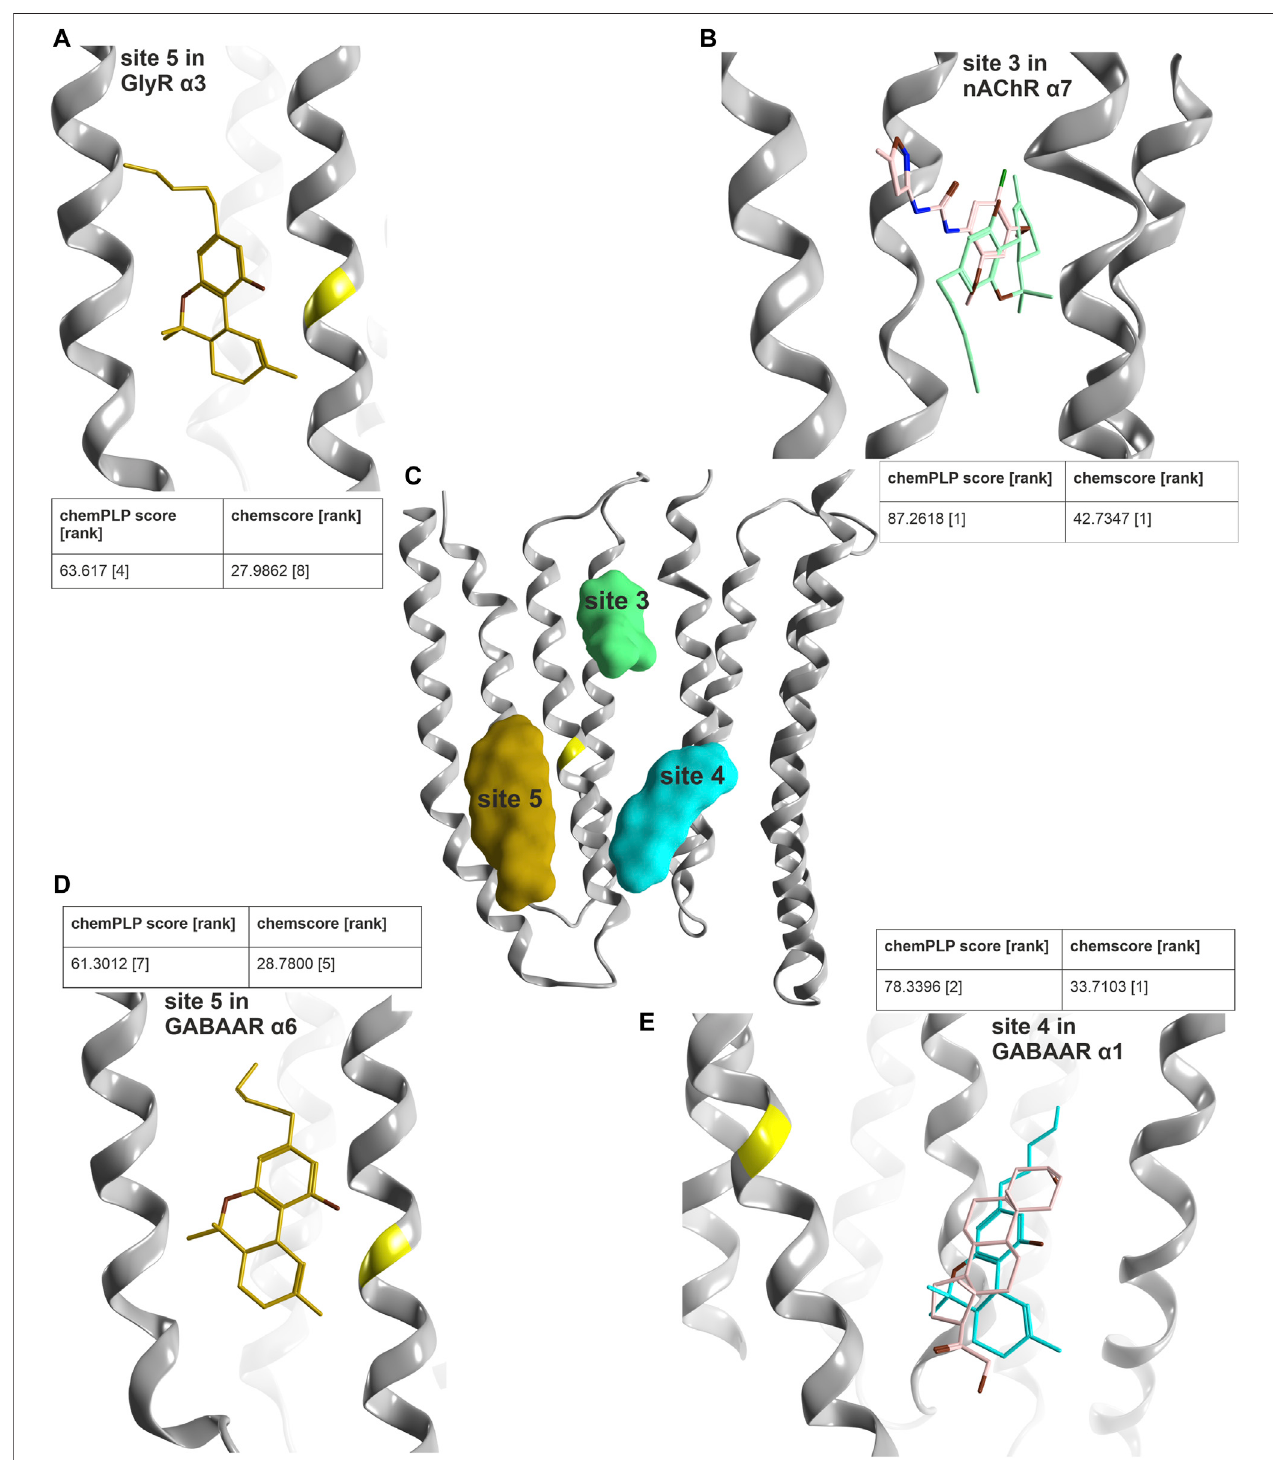
FIGURE 9 | Computational docking into candidate binding sites for Δ 9 -THC. (A) Consensus binding mode for site 5 in the GlyR α 3 subunit from 5VDI which isalso present in the GABA A R α 6 docking in panel (D) . (B) The highest ranked consensus scored representative binding mode from the docking into site 3 from 7EKT with Δ 9 - THC inbluesuperposed withPNU-120596 inpink. (C) Allthree sitesofinterestdisplayed onarepresentative ribbonstructure withGlyR α 3Ser307indicatedbyayellow segment on TM3. (D) Docking result of Δ 9 -THC into site 5 of a GABA A R α 6 homology model. (E) Representative binding mode from the docking into 5OSB superposed with THDOC in pink.